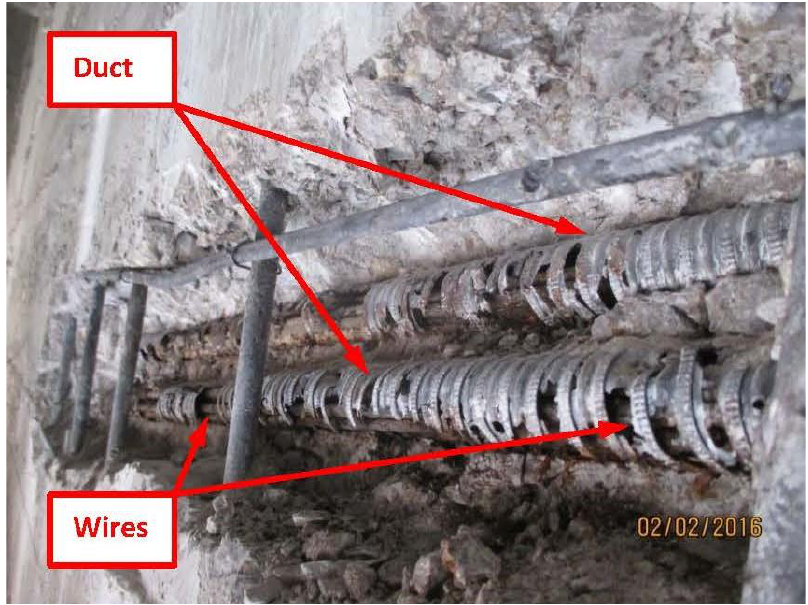
Figure 2. Sampling spot of corroded wires with 40-mm diameter ducts.